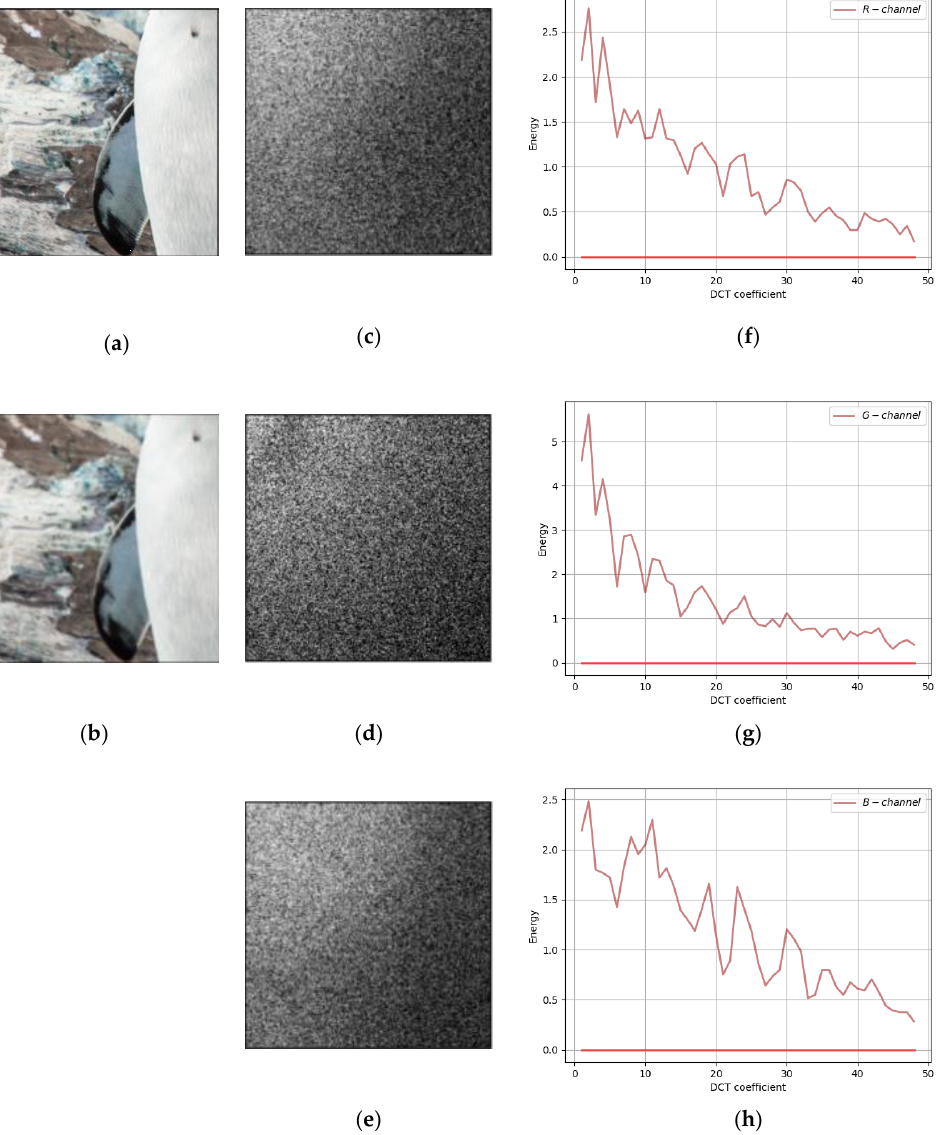
Figure 7. A frequency-domain residual analysis of SteganoGAN. ( a ) Cover Image; ( b ) Steganographic Image; ( c ) R-channel DCT Domain Residual; ( d ) G-channel DCT Domain Residual; ( e ) B-channel DCT Domain Residual; ( f ) R-channel DCT residual curves; ( g ) G-channel DCT residual curves; ( h ) B-channel DCT residual curves.